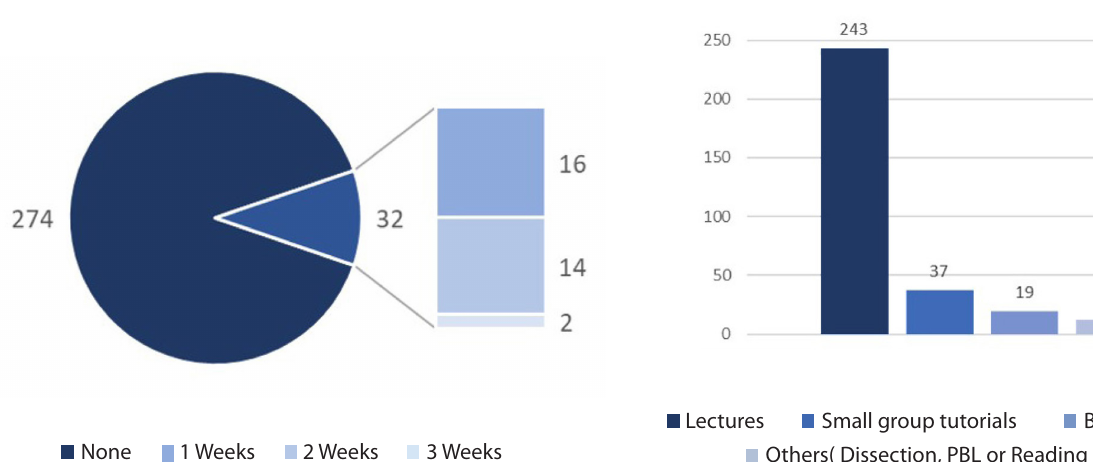
Fig. 2 - Breakdown of the teaching methods for cardiothoracic surgery. PBL=problem-based learning